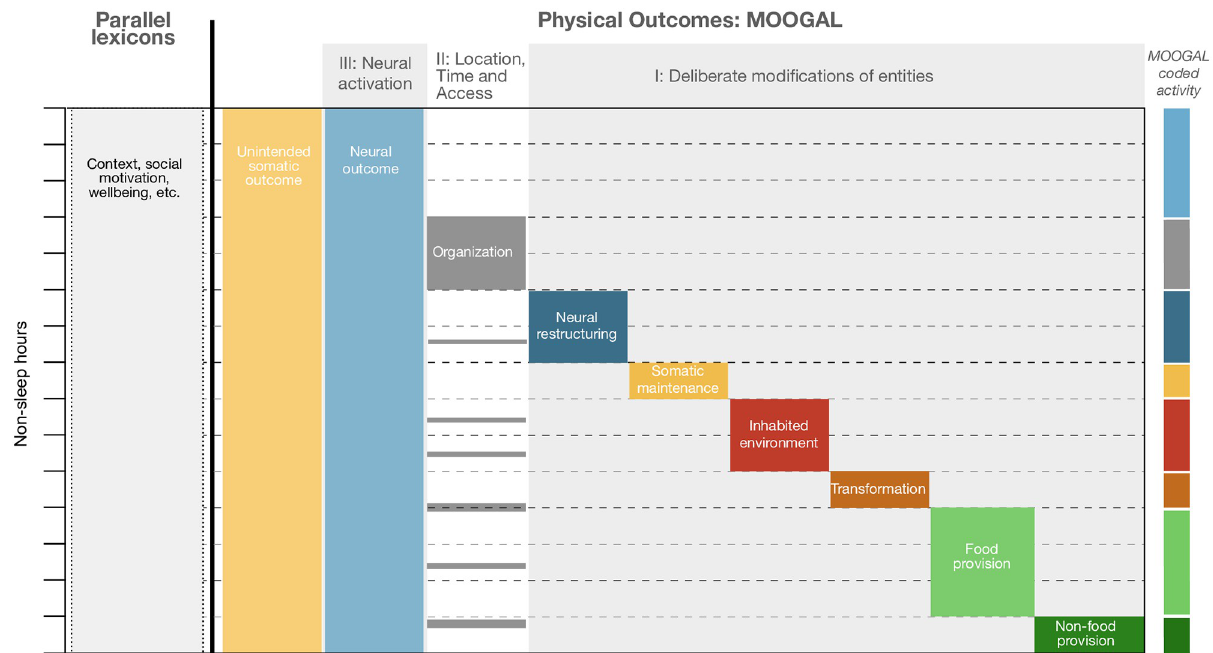
Fig 2. Prioritization of simultaneous outcomes. Schematic illustration of how simultaneous outcomes can occur, in relation to the prioritization scheme. Simultaneous outcomes are those which co-occur horizontally. For example, many organization outcomes (thin grey bars) could co-occur with deliberate modification activities throughout the day, but are not identified as the motivating outcomes because they are lower priority. Similarly, somatic and neural outcomes are always occurring, but somatic outcomes are only identified when they are the primary deliberate outcome, and neural outcomes are only identified when not co-occurring with one of the tier I or II outcomes. Context, social motivation and wellbeing (left-hand side) are not captured by the MOOGAL, but are examples of dimensions of time use that could be addressed with additional parallel lexicons.